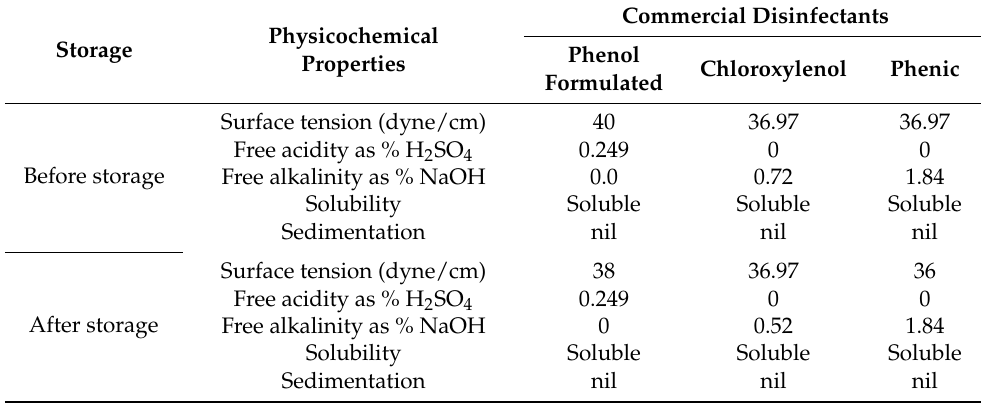
Table 3. Physicochemical properties of disinfectants before and after storage at (54 ± 3 ◦ C) for three